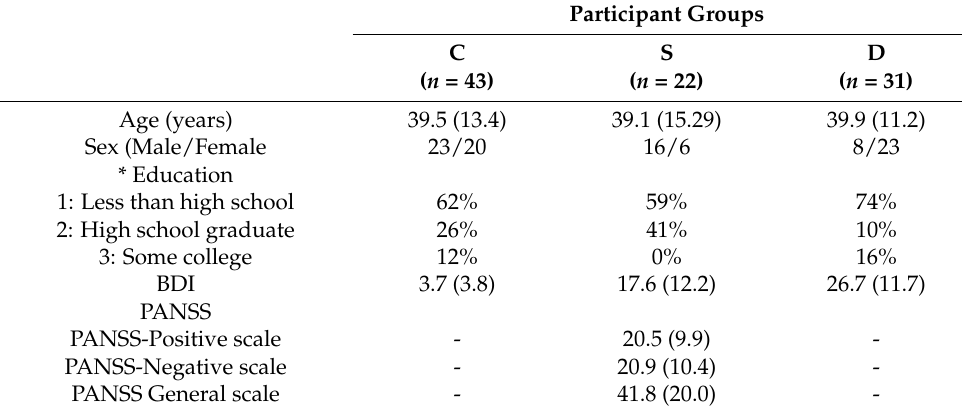
Table 1. Sociodemographic and clinical